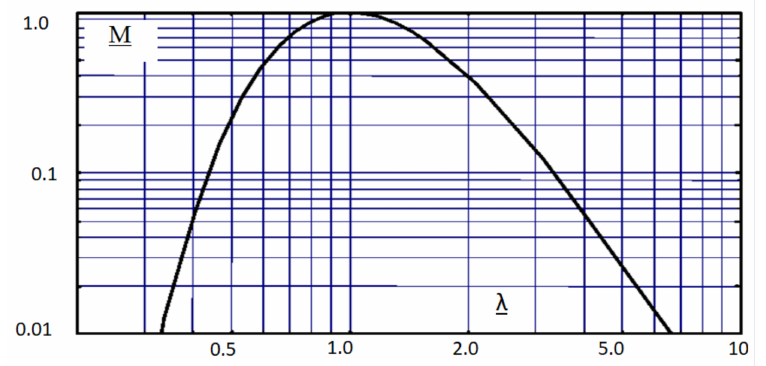
Figure 11. Generalized graphical interpretation of Planck’s law (1) given in relative units M = f ( λ )